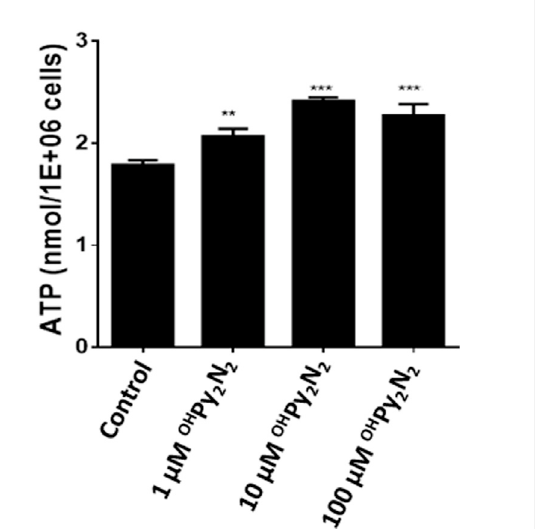
FIGURE 7 ATP production is increased with the addition of OH Py 2 N 2 . LECsweretreatedwith(1 – 100 µm) OH Py 2 N 2 for24 h.Control cells were treated identically but without additional of OH Py 2 N 2. Whole cell homogenates were used for ATP measurement with